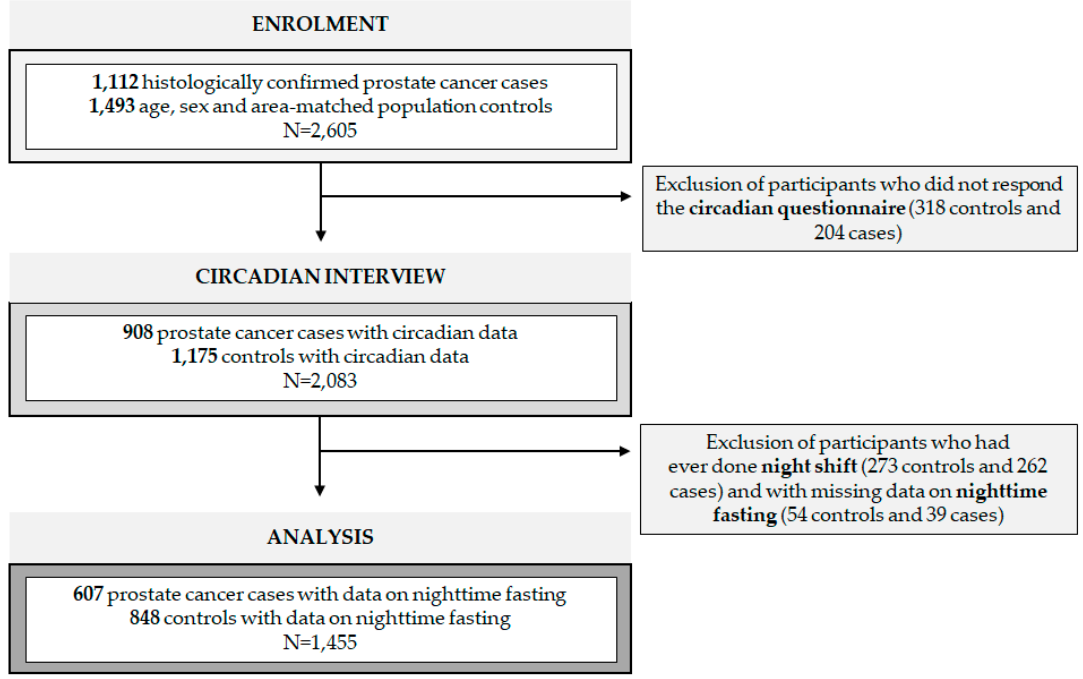
Figure 1. Flow chart of study population. N = sample size.